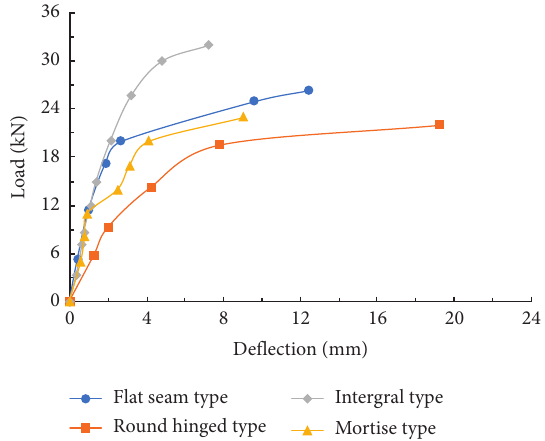
Figure 5: The midspan deflection-load curve of top slab of various